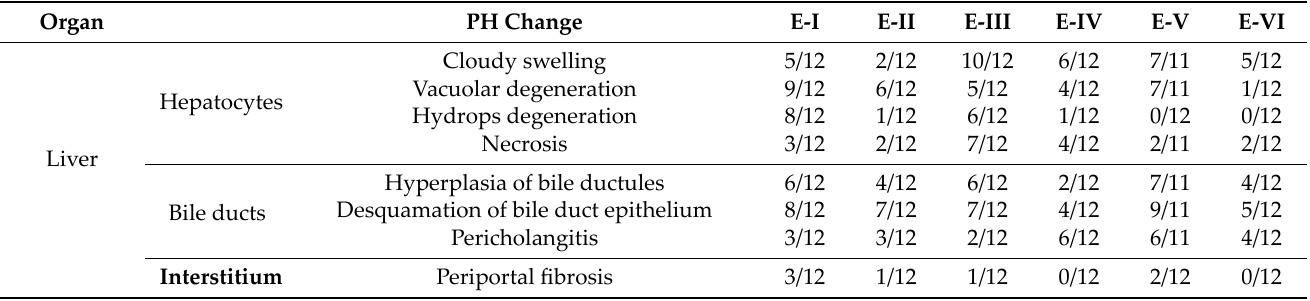
Table 8. The score of the PH changes in liver of broilers chicks fed with diets containing AFB1 and T‑2 toxin combination in relation to the numbers of animals examined.